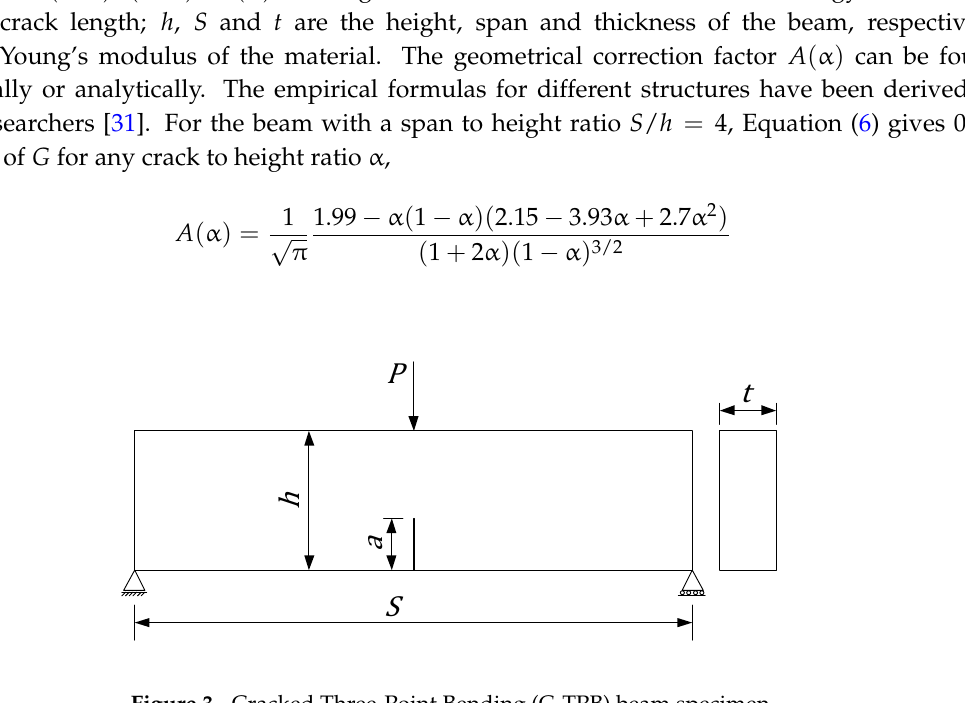
Figure 3. Cracked Three-Point Bending (C-TPB) beam